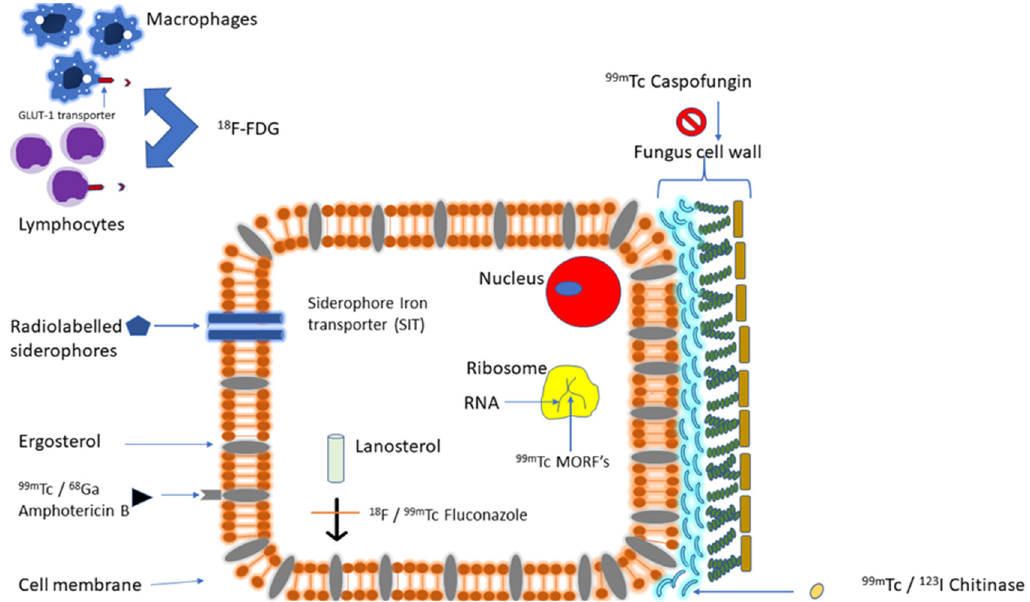
Figure 2. A schematic diagram of the fungal cell and surrounding inflammatory cells (macrophages and lymphocytes). [ 18 F]FDG is mostly taken up by host inflammatory cells that are abundantly present at the sites of invasive fungal disease. Radiolabeled siderophores produced by ex vivo labeling of synthetic siderophores or in vivo labeling of fungal-produced siderophores following administration of radiogallium are trapped by the fungal cell via siderophore–iron transporter expressed in the fungal cell membrane. Fluconazole, amphotericin, and caspofungin are anti-fungal agents that have been radiolabeled for specific targeting of fungal agents in IFD. Radiolabeled chitinase targets the fungal cell wall in fungal-specific imaging. Morpholino oligomers (MORFs) target fungal messenger ribonucleic acid (RNA) and provide a specific means of targeting fungal organisms.